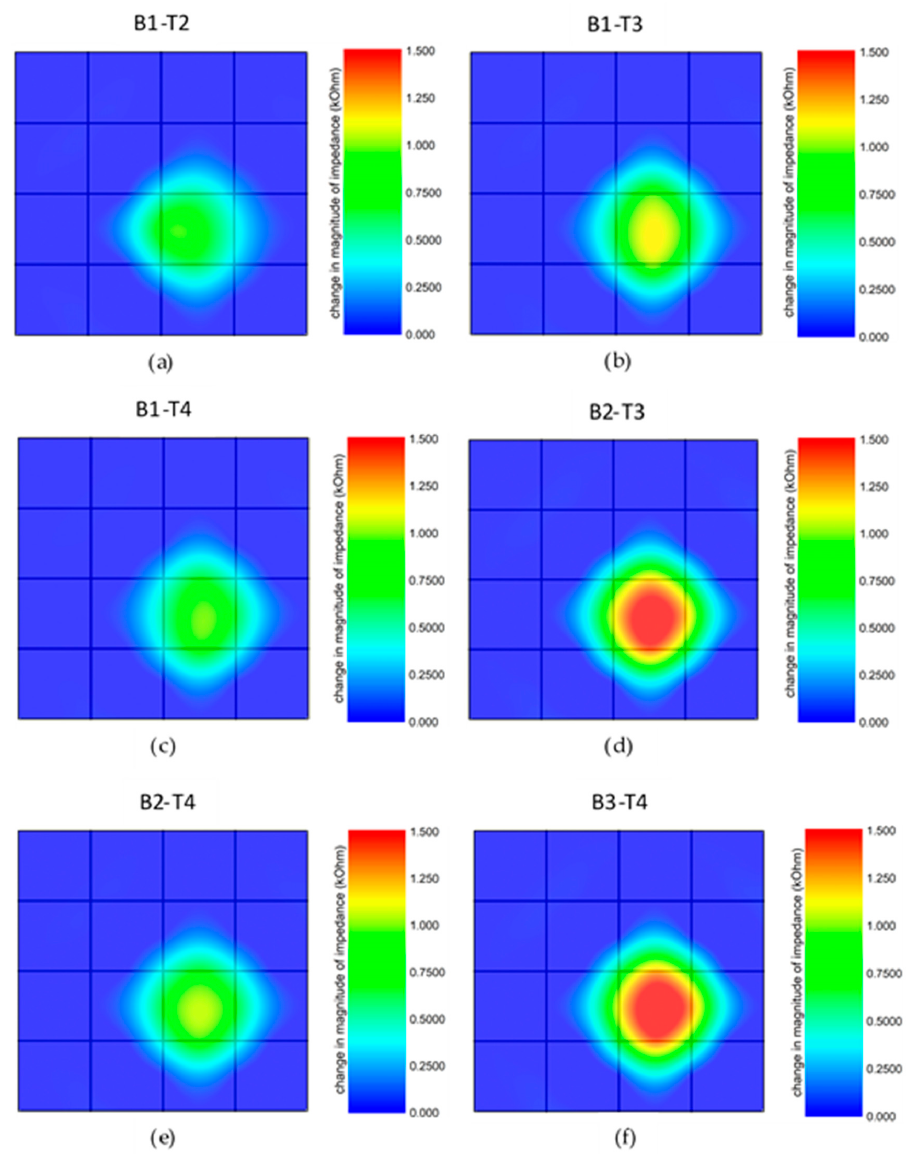
Figure 10. ( a – f ) The impedance distribution maps of the tactile sensor for the pressure applied on the specific region (labeled as 11 in Figure 4c) of the array obtained using different measurement pads. specific region (labeled as 11 in Figure 4c) of the array obtained using di ff erent measurement